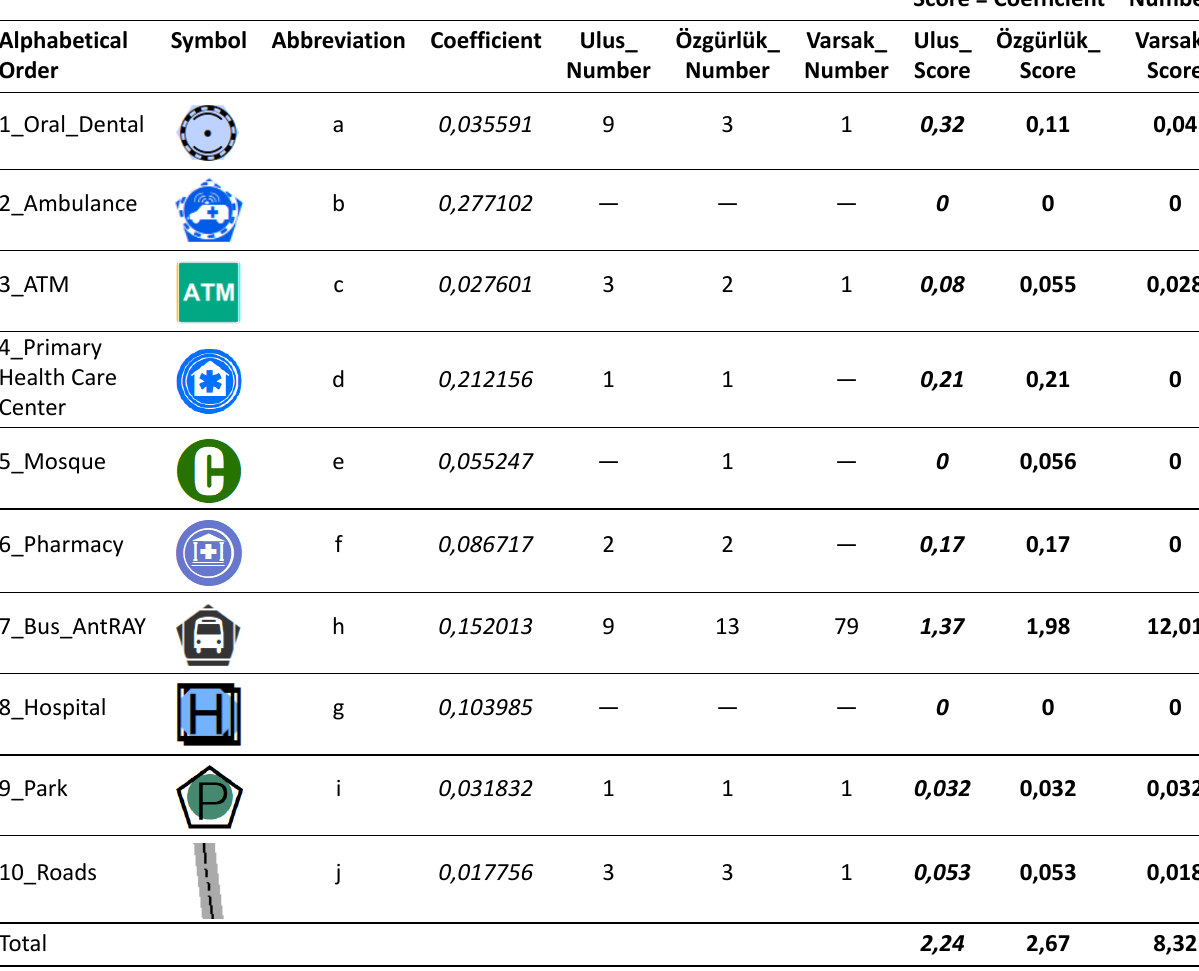
Score = Coefficient *